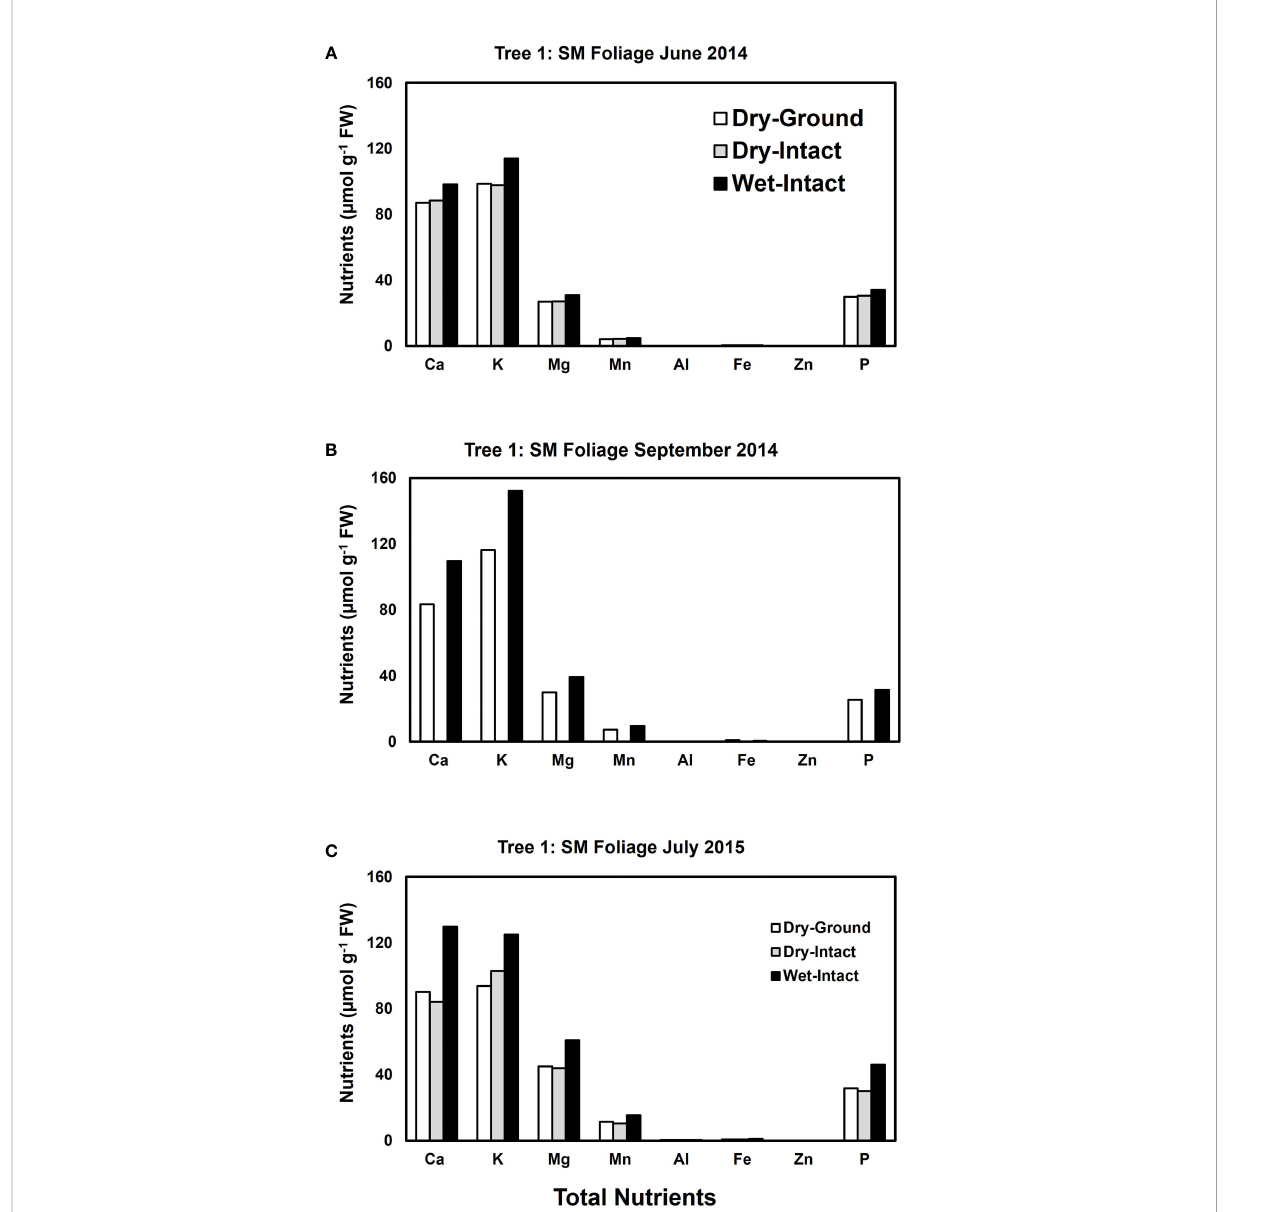
FIGURE 2 Comparison of three tissue preparation methods for the extraction of total inorganic nutrients from sugar maple foliage. Data presented here are from three collections from a single tree in: June 2014 (A) ; September 2014 (B) ; and July 2015 (C)